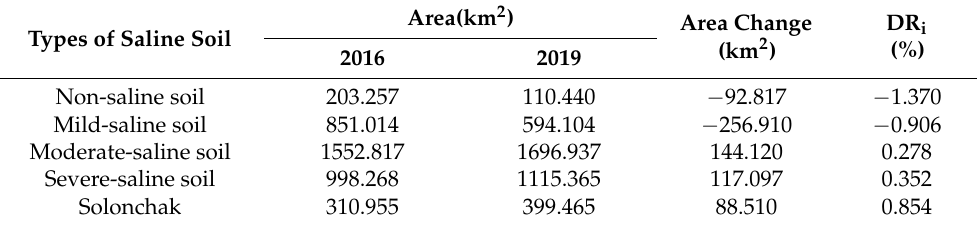
Table 10. Statistical table of dynamic changes of different types of saline soil.